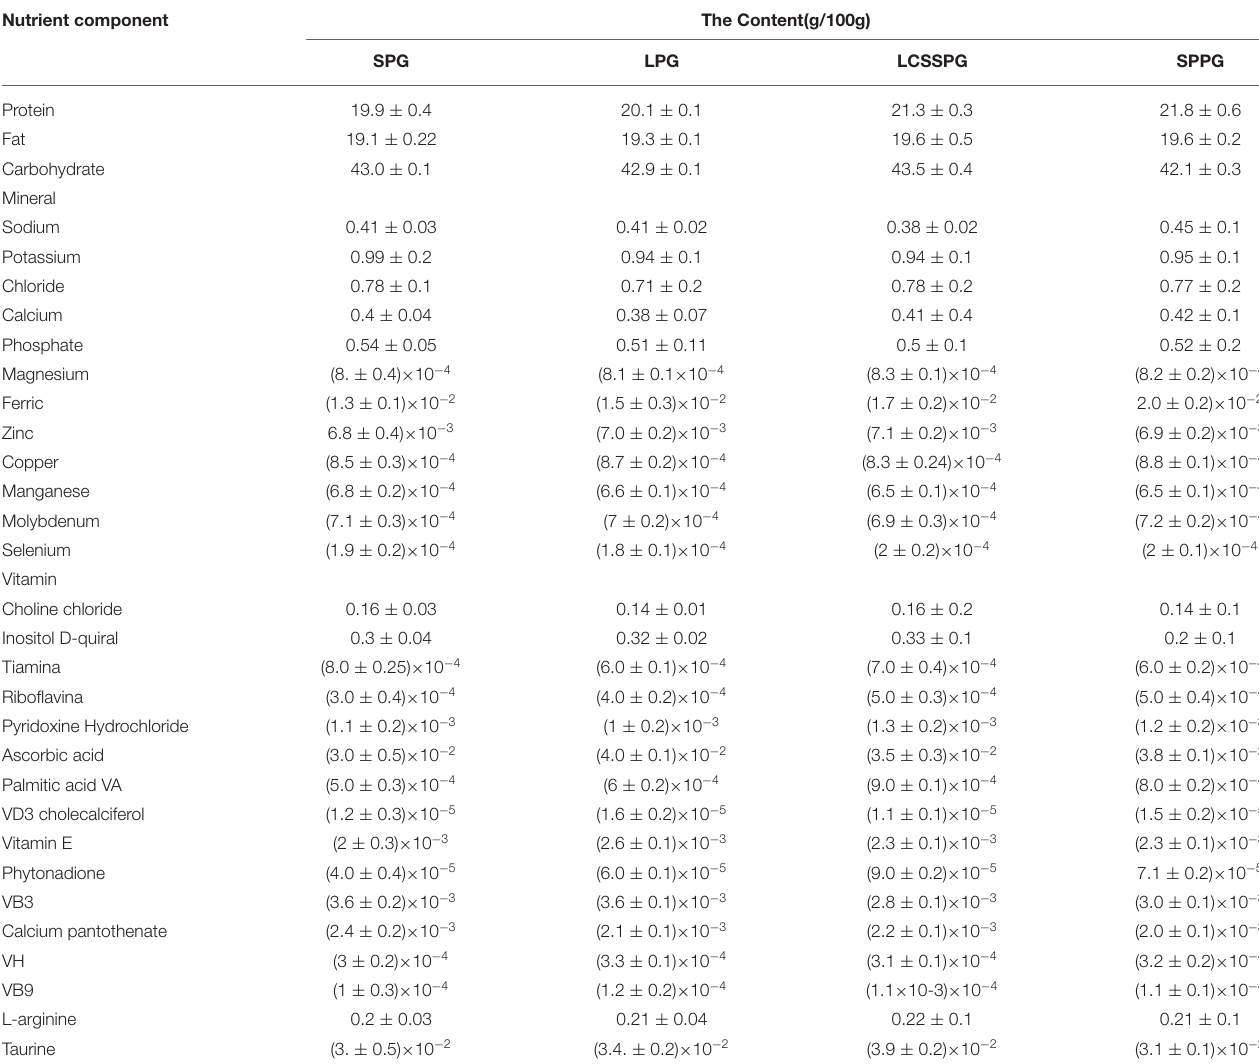
TABLE 4 | Formulations of enteral nutritional formula. Nutrient